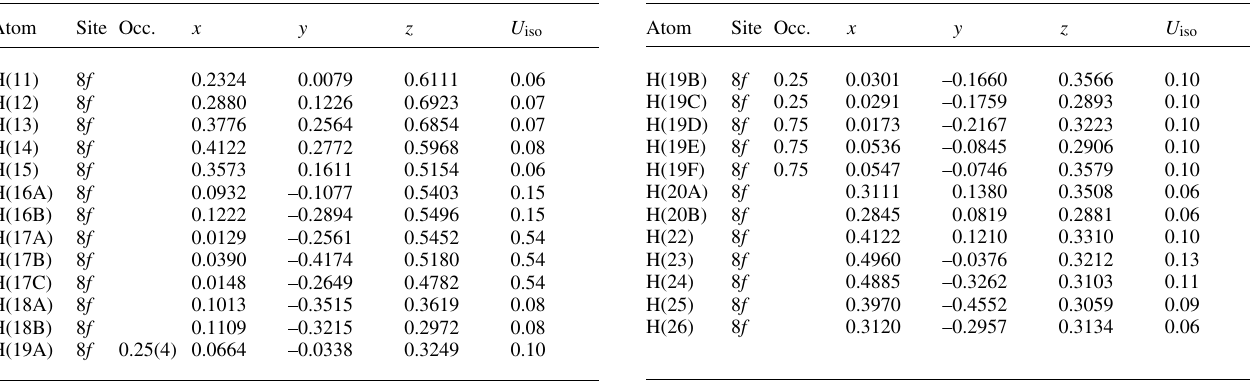
Table 2. Atomic coordinates and displacement parameters (in Å 2 )